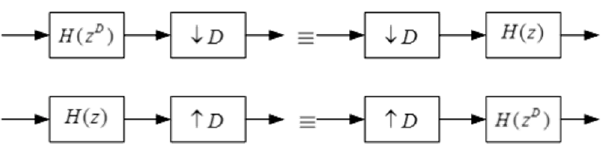
Figure 11. Equivalent relationships of filter banks.